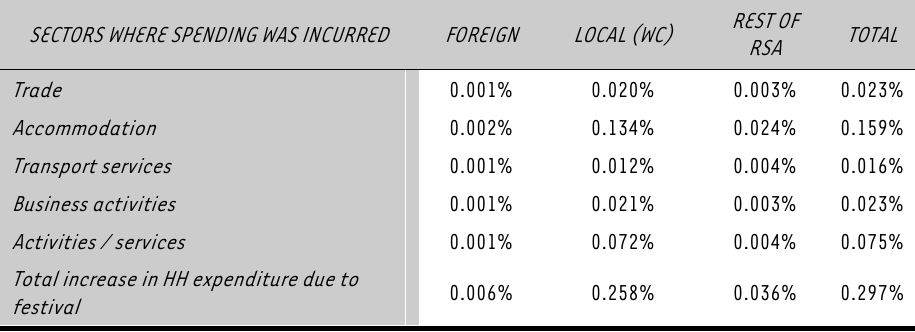
Spending of visitors at the KKNK (% change) SECTORS WHERE SPENDING WAS INCURRED